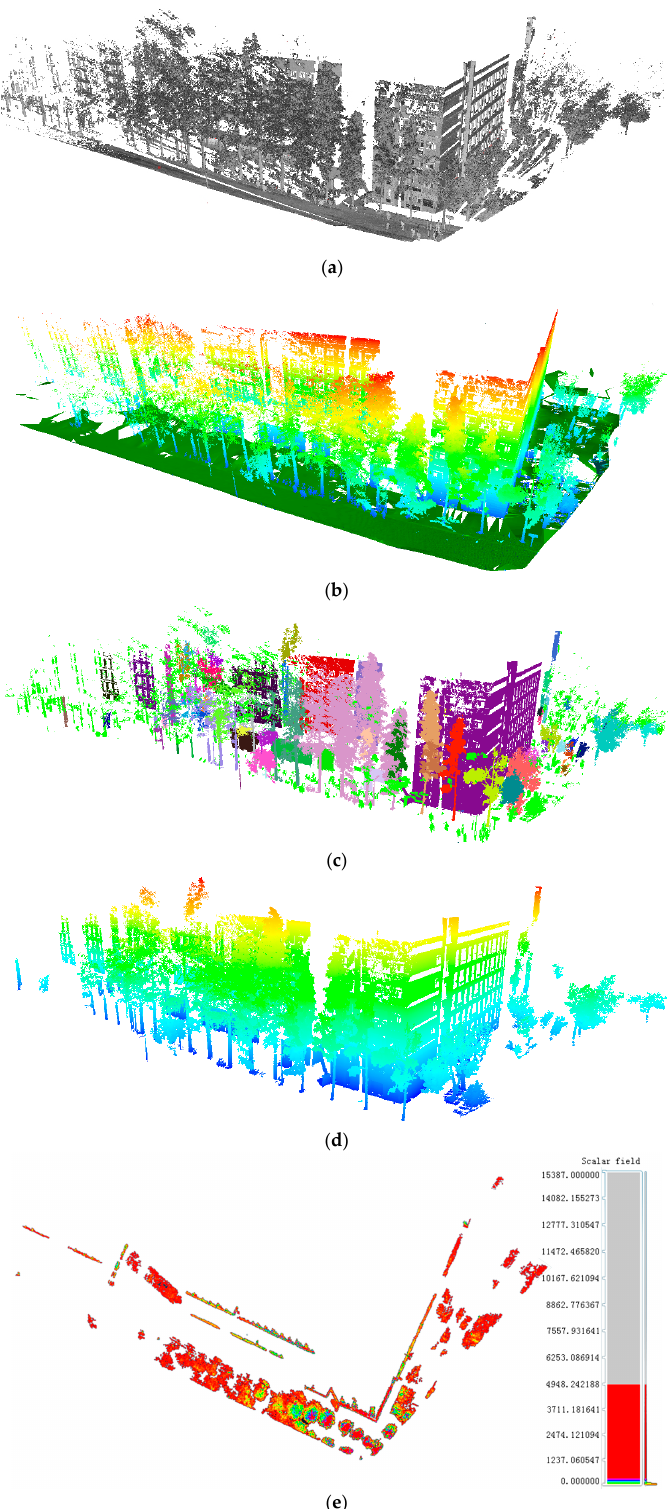
Figure 3. Transformation from 3D to 2D: ( a ) original points; ( b ) ground filtering; ( c ) clustering result with small clusters colored by green; ( d ) filtering result and the number of points is 3,407,526; and ( e ) projecting result and the number of points in each block is rendered by different colors of the block center. The number of points is 27,706.